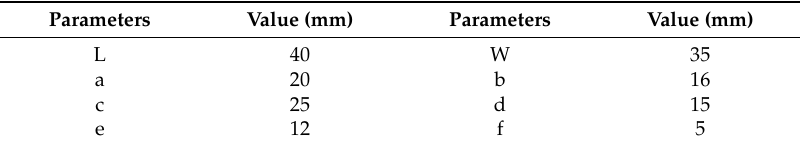
Table 1. Design parameters of the proposed antenna.